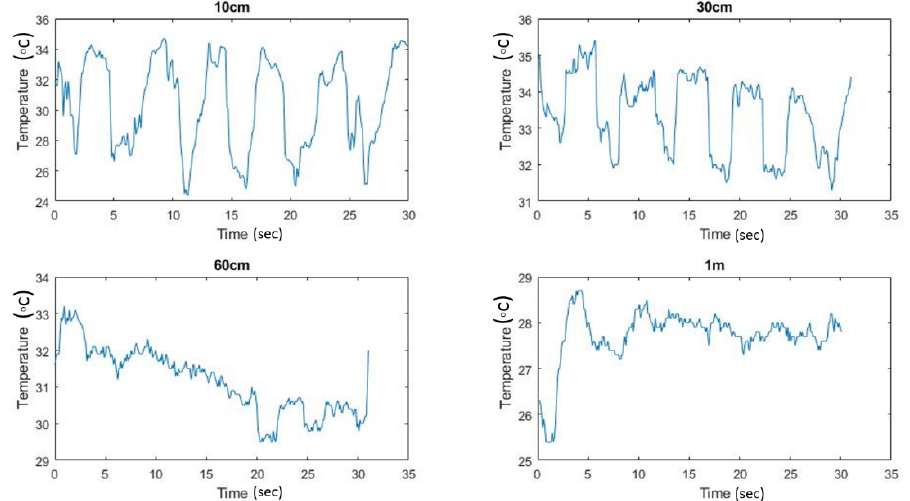
Figure 9. Respiration signals recorded at 10 cm, 30 cm, 60 cm, and 100 cm.